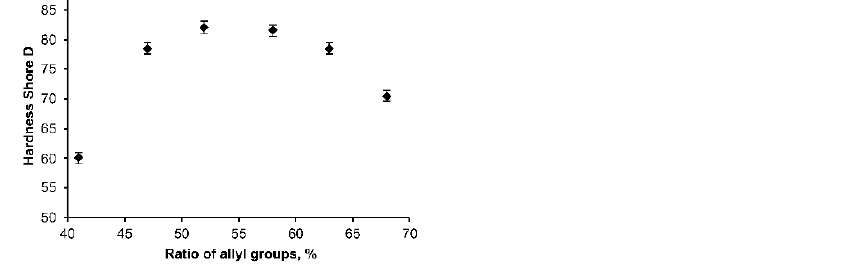
Figure 4. Dependence of the shift force on the concentration of silane in the OSTE-MS polymers. It turned out that the mechanical characteristics of the OSTE-MS polymers studied in this work were dramatically determined by the silane content in the polymer. With an increase in the silane concentration, there was a significant decrease in tensile strength and a decrease in Young’s modulus (Figure 5). Thus, at silane contents of 6.4, 12.1, and 17.1 wt.%, the values of tensile strength were 58, 19, and 13 MPa, and the values of Young’s modulus were 1.7, 0.4, and 0.1 GPa, respectively. Perhaps this is due to the fact that when MS interacted with TATATO, the TATATO had no more than two allyl groups, which led to an increase in linear fragments and a decrease in crosslinks (Figure S1).